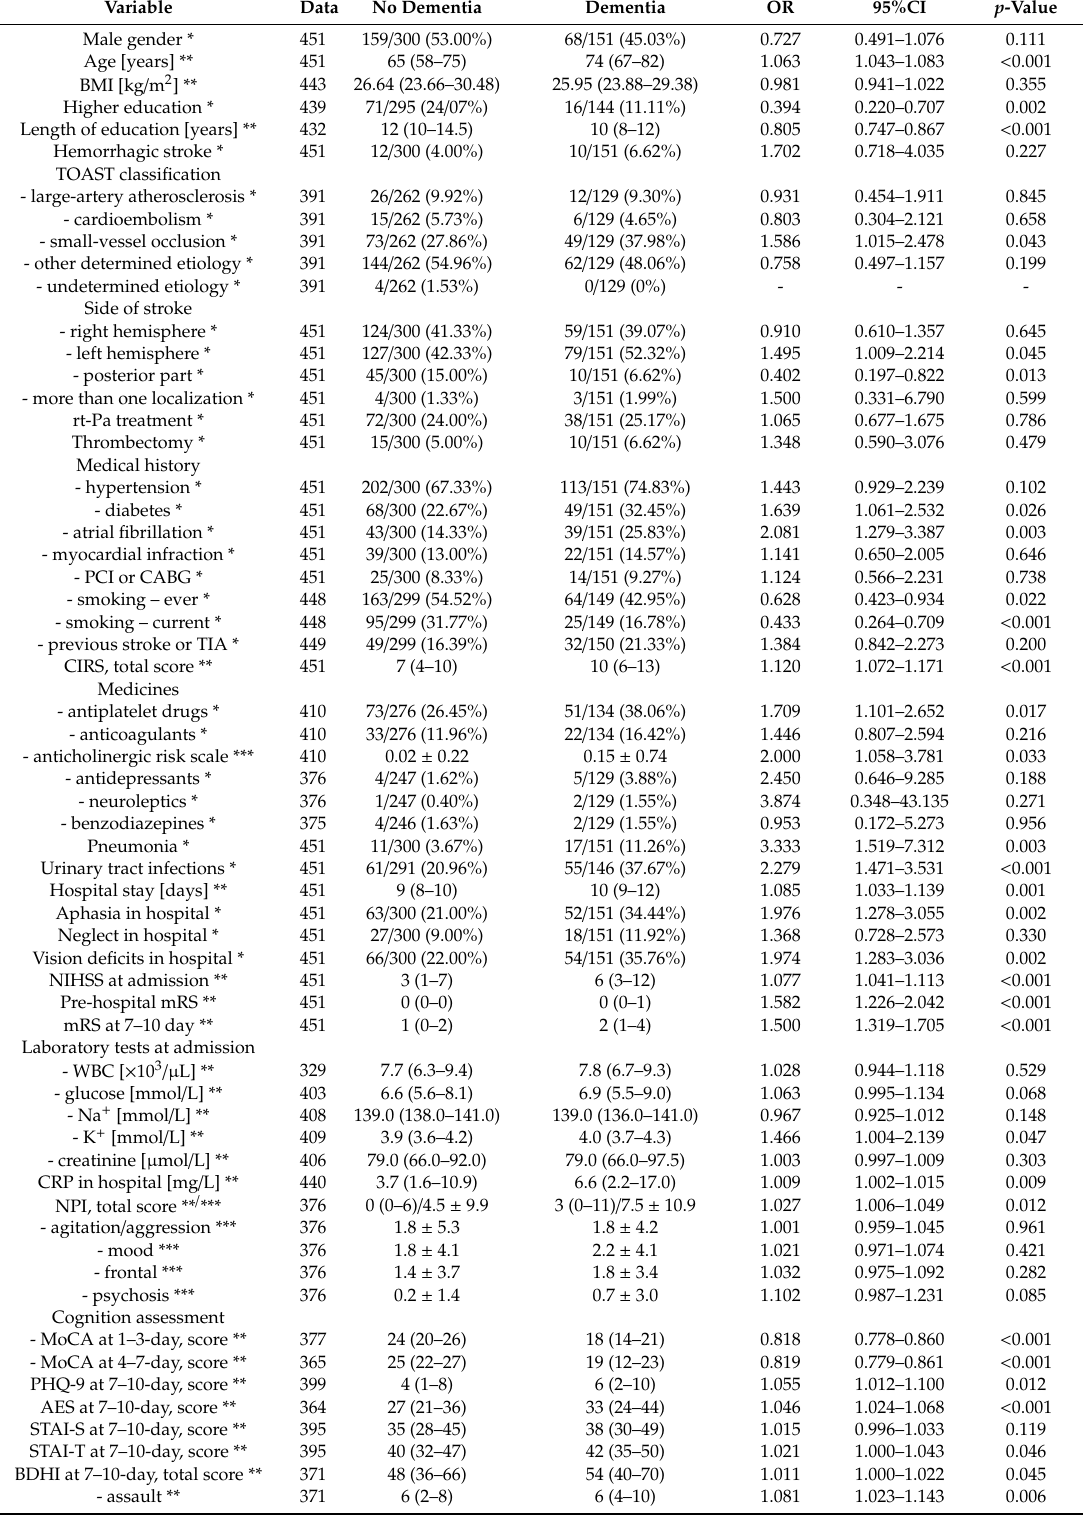
Table 4. Predictors of post-stroke dementia at the twelve-month follow-up in the univariate logistic regression